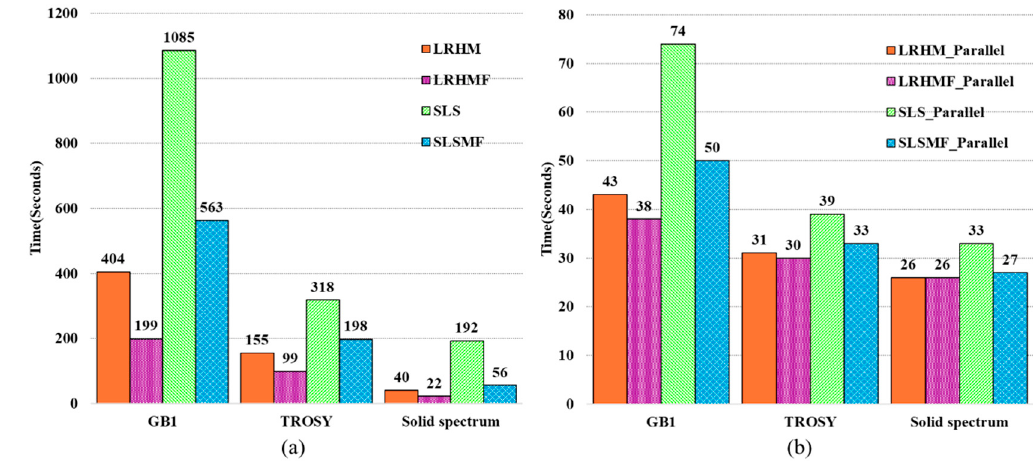
Figure 11. The computation time of spectra reconstruction on a computational server using the LRHM, LRHMF, SLS, and SLSMF methods. ( a , b ) computation time of spectra reconstruction without and with parallel computing, respectively. Note: The switching on and off parallel pool takes an average of 24 s.